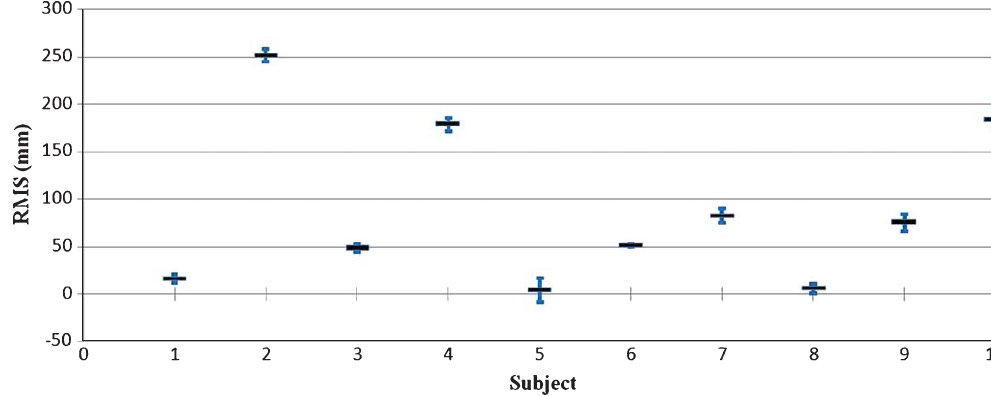
Fig. 12. RMS and standard deviation of the error between CoM estimation based on a SESC and CoM estimation based on anthropometric tables –